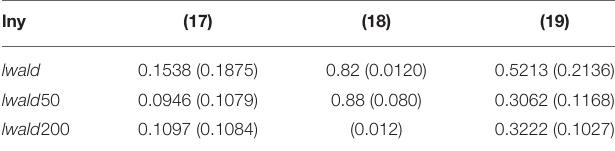
TABLE 8 | Optimal broadband estimation